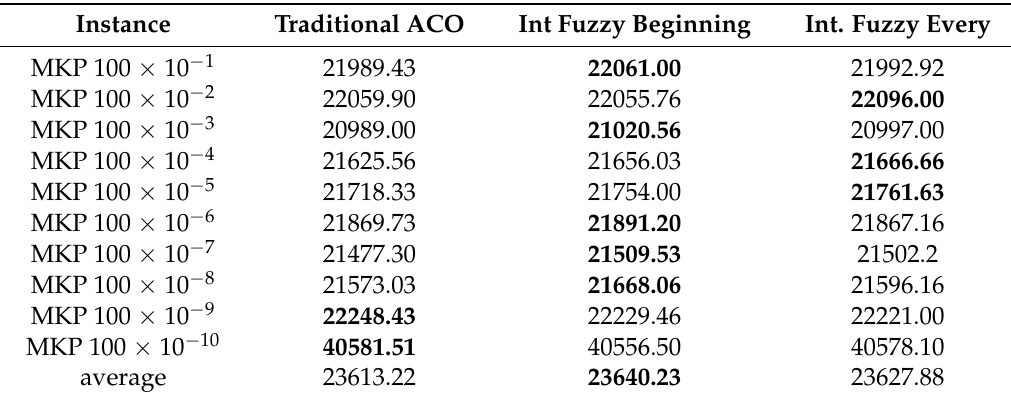
Table 2. ACO performance with different pheromone